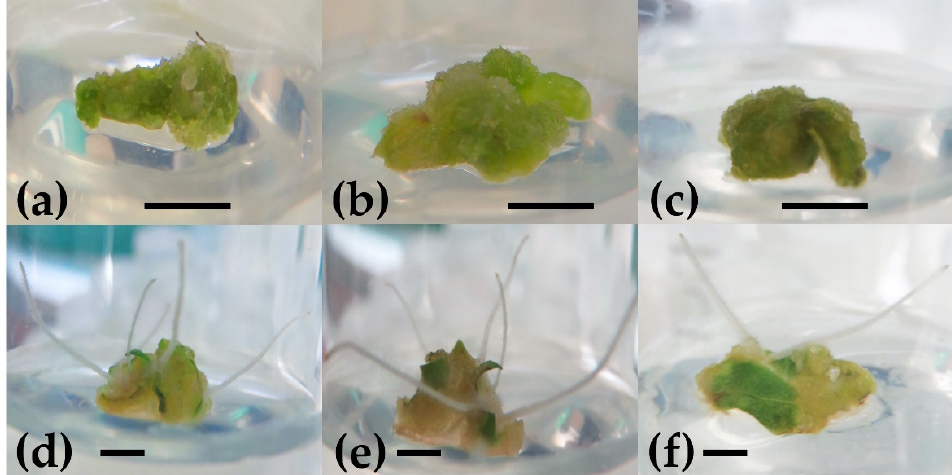
Figure 2. Morphogenetic responses of leaf explants after 15 days of their incubation: ( a ) KIN (0.1 mg/L) with PIC (1.0 mg/L), ( b ) BAP (0.1 mg/L) with PIC (1.0 mg/L), ( c ) BAP (0.1 mg/L) with 2,4-D (0.1 mg/L), ( d ) KIN (0.1 mg/L) with NAA (1.0 mg/L), ( e ) KIN (0.1 mg/L) with 2,4-D (1.0 mg/L), ( f ) BAP (0.1 mg/L) with NAA (1.0 mg/L). Scale bar = 10 mm.